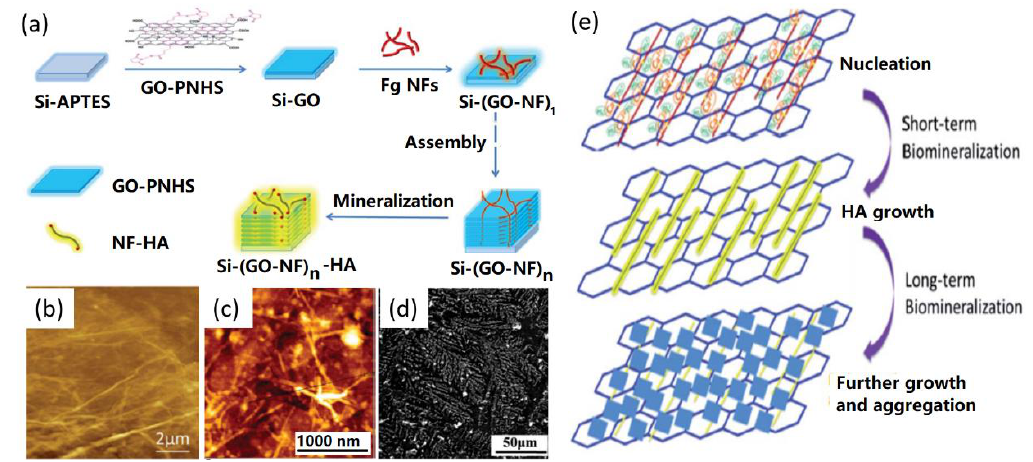
Figure 4. GO-nanofibers (NFs) for HA biomimetic mineralization: ( a ) Synthesis process, ( b ) AFM image of GO-NFs, ( c ) AFM image of GO-NFs after mineralization for 2 h, ( d ) SEM image of GO-NFs after 14 days mineralization, and ( e ) possible biomimetic synthesis mechanism of HA on GO-NFs. Reproduced with the permission from ref. [29]. Copyright 2014 Royal Society of Chemistry.